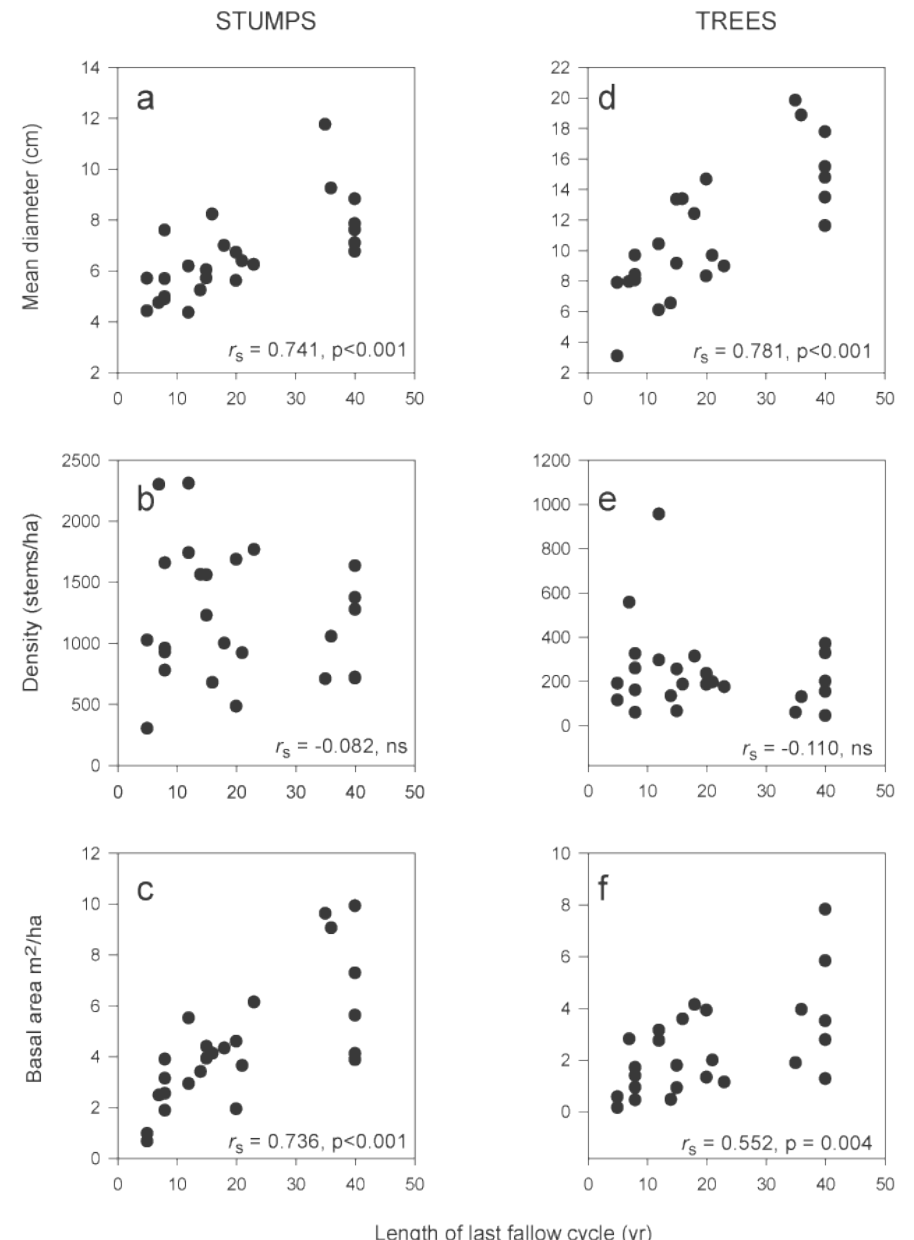
Fig. 4. Scatterplots of mean diameter, density, and basal area against length of the last fallow cycle for spared stumps (a–c) and spared trees (d–f). Data based on the 25 firewood species only. Spearman rank correlations and significance levels from Table 3 are indicated in the bottom right corner of each